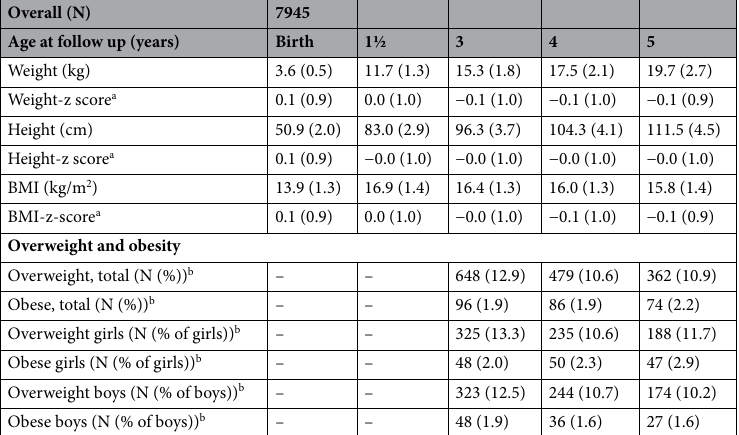
Table 2. Characteristics of children. N numbers of observations. Data represent the mean (SD), unless otherwise indicated. a Sex and age independent standard deviation scores (z-scores) were calculated using the Swedish reference population. b Revised international (International Obesity Task Force; IOTF) BMI cut ‐ offs (kg/m 2 ) using the pooled LMS